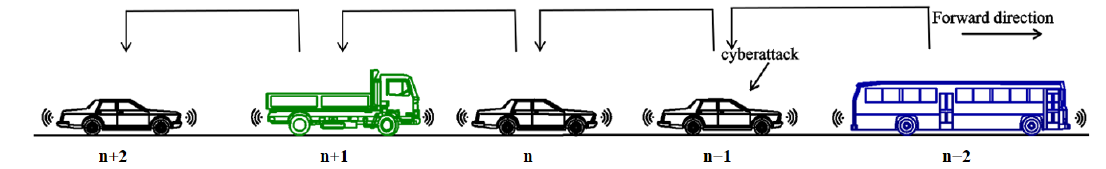
Figure 1. Schematic diagram of mixed CAV flow for multiple types of vehicles.